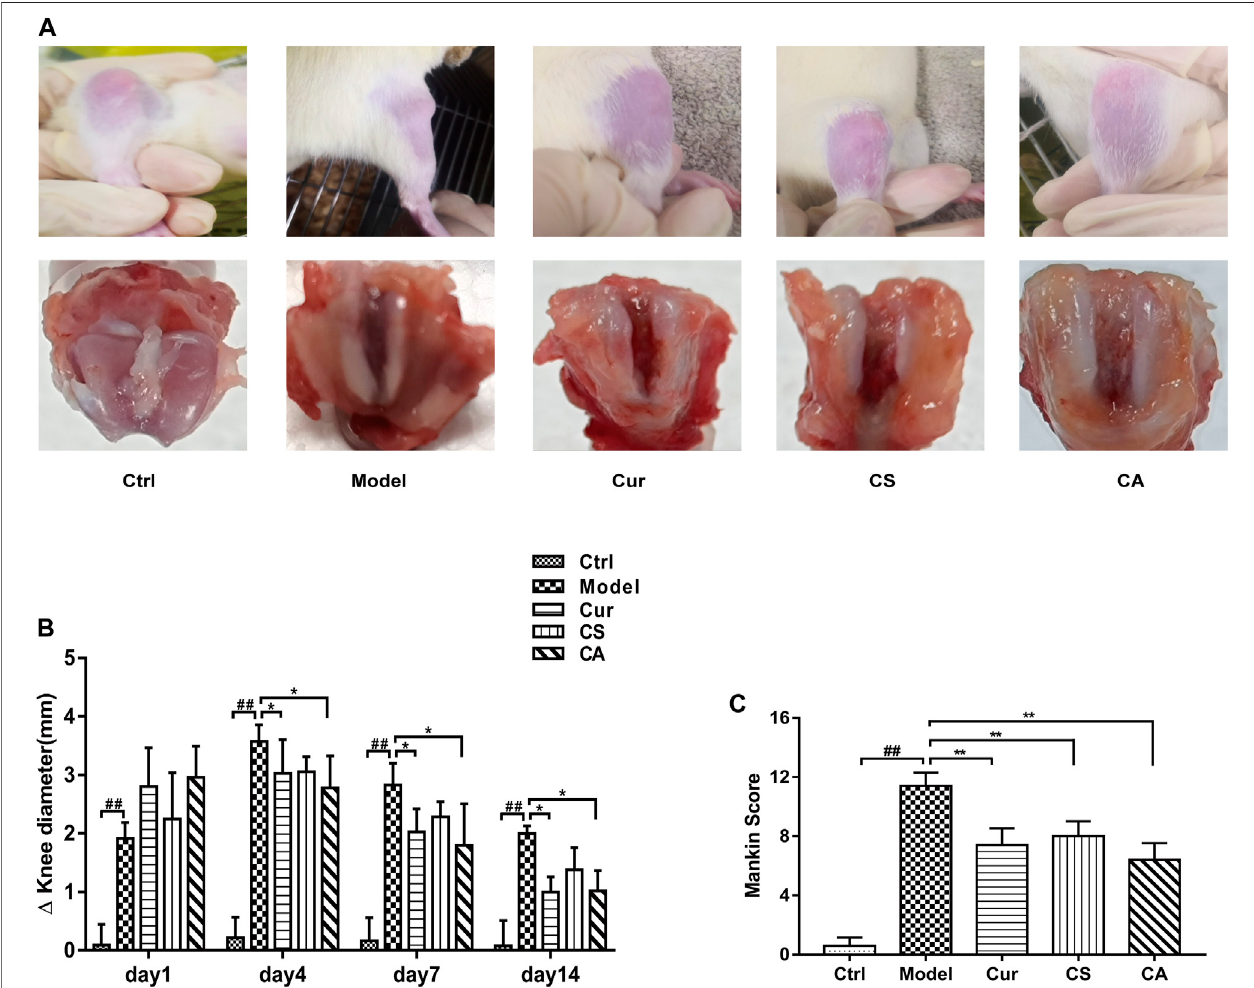
FIGURE 1| Effect ofdifferenttreatments on knee osteoarthritis in MIA-induced rats. (A) Representative image of knee joint in each group. (B) Knee joint diameters of each group ( n = 6). (C) Mankin scoring of each group ( n = 5). Data are presented as mean ± SD. ## p < 0.01 vs. Ctrl group; * p < 0.05, ** p < 0.01 vs. model group.